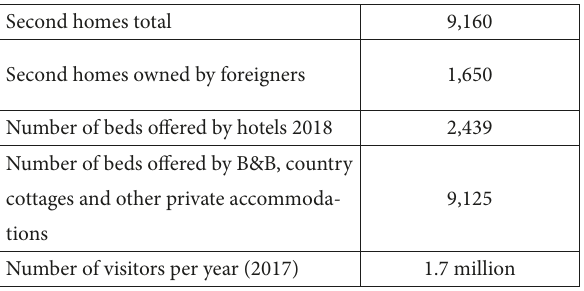
Table 1 Data on tourist activity in the Gers in 2018 (Source: Depart- mental Committee of